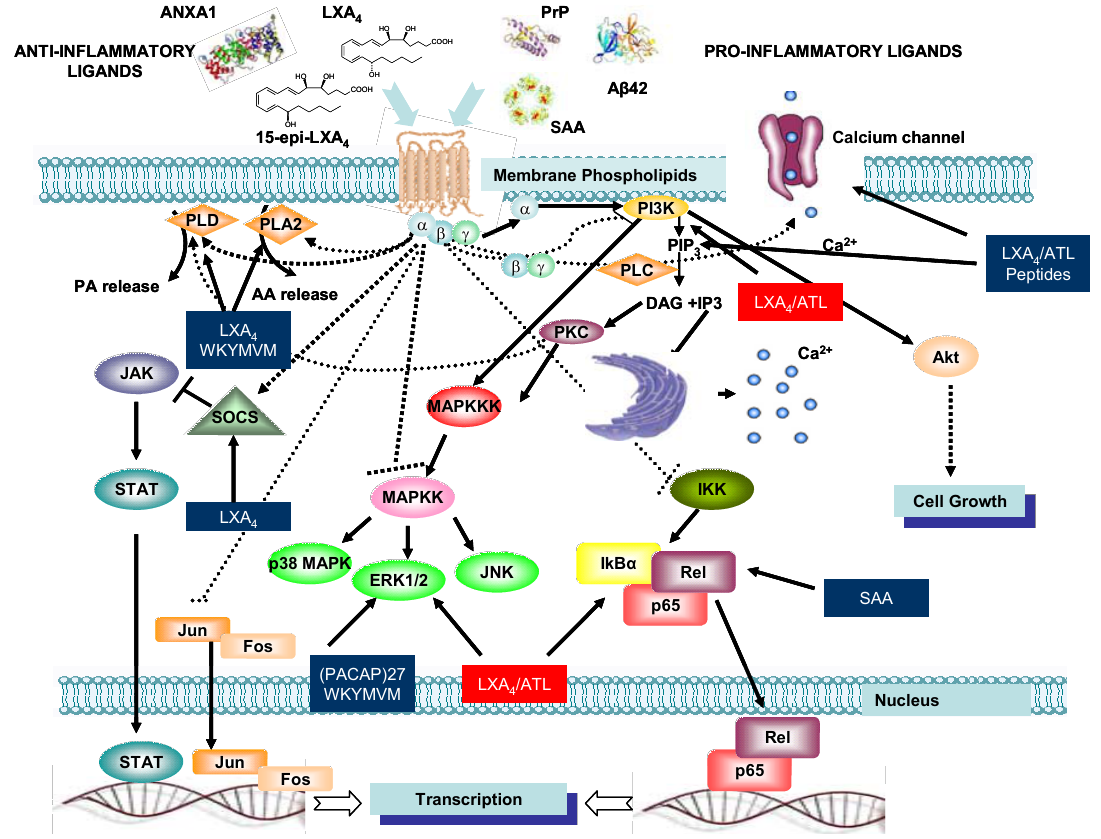
FIGURE 5 . Intracellular signaling of ALX. Positive agonists are in the blue boxes, inhibitors are in the red boxes (see text for details).